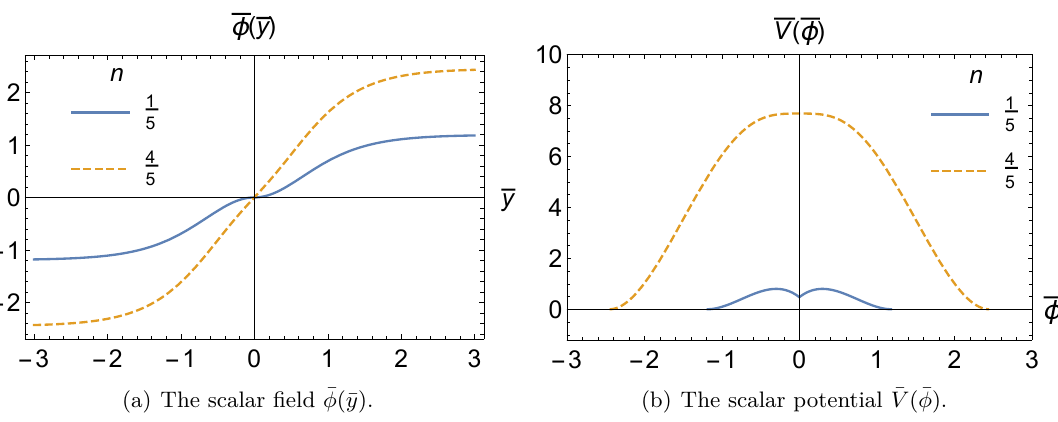
Figure 8 . Plots of the dimensionless scalar field ¯ φ (¯ y ) and the corresponding dimensionless scalar potential ¯ V (¯ φ ) in